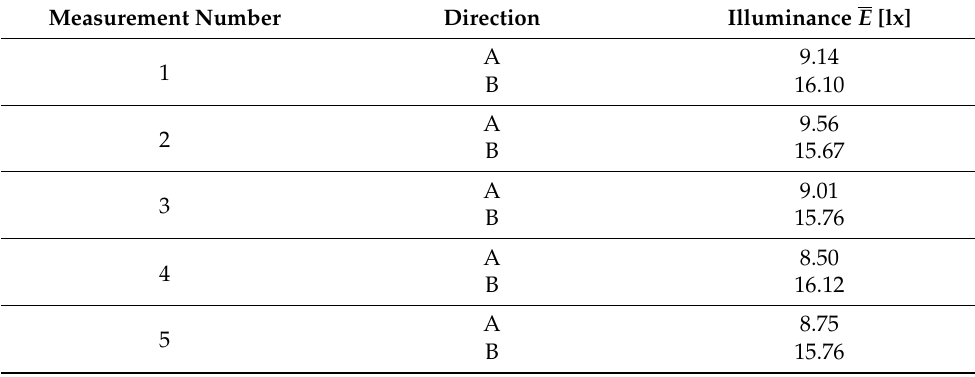
Table A1. Example of the results for measurement field No. 2.